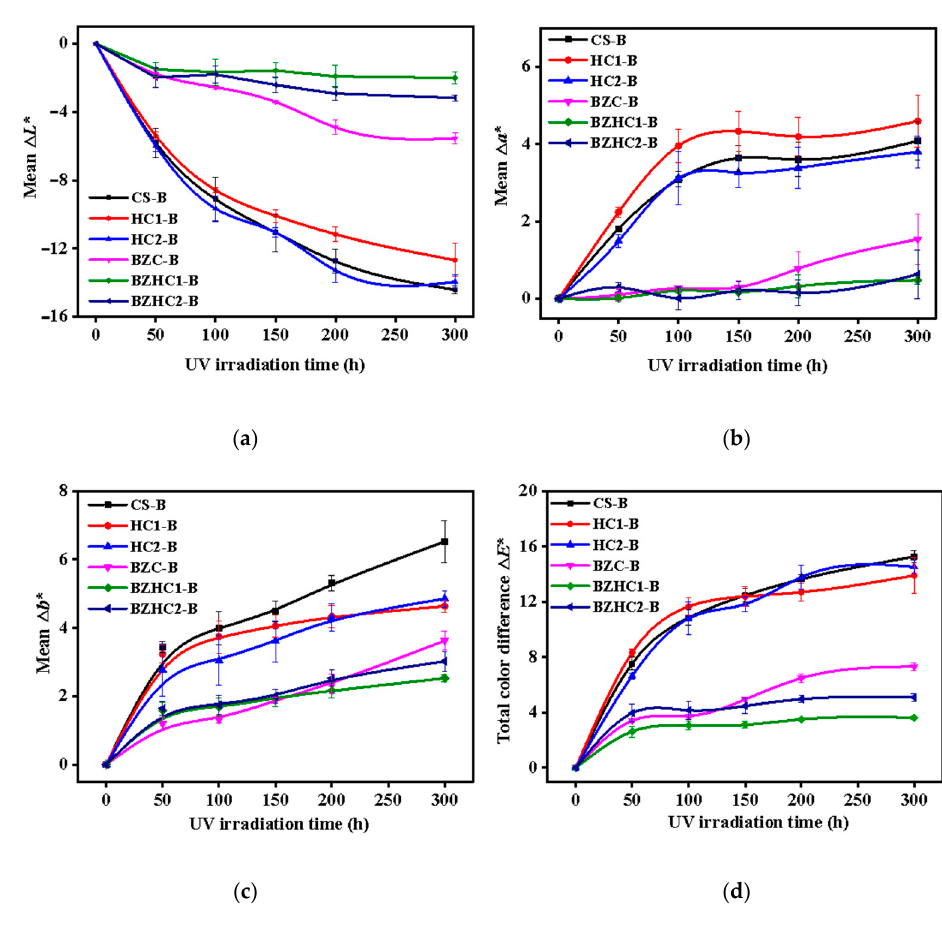
Figure 3. Changes of L *, a *, b * and Δ E * of OBS during weathering. All samples showed an obvious increase in the colorimetric parameter b * after expo- sure. Sample CS-B showed the greatest change in b * (towards yellow) with a ∆ b * of 6.52 [41]. Samples HC2-B and HC1-B had ∆ b * of 4.85 and 4.63, respectively. Similar to the results for ∆ L * and ∆ a *, the sample of BZHC1-B with stereoscopic protective coating exhibited the best stability in b * and its ∆ b * was only 2.52, which is approximately 38.65% of the ∆ b * of